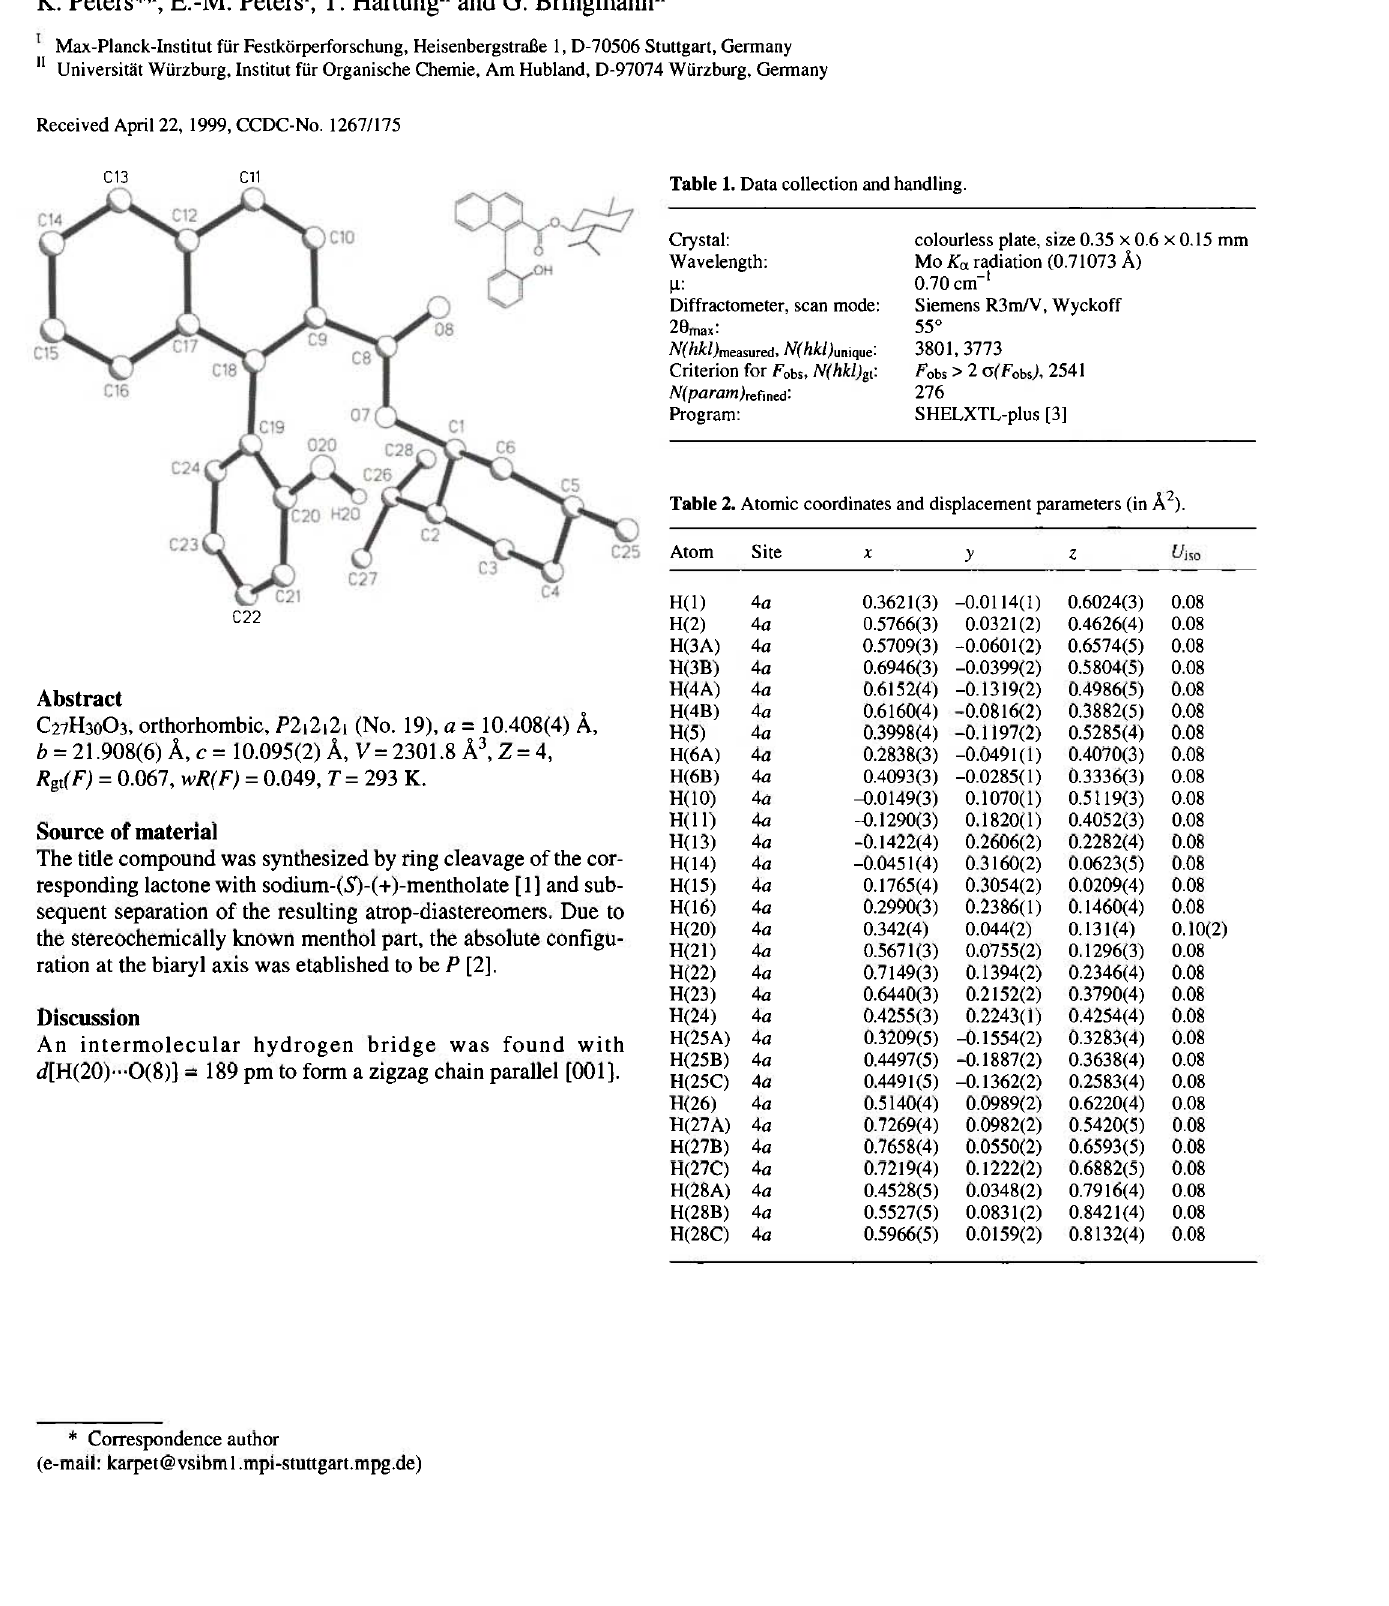
Table 1. Data collection and handling.